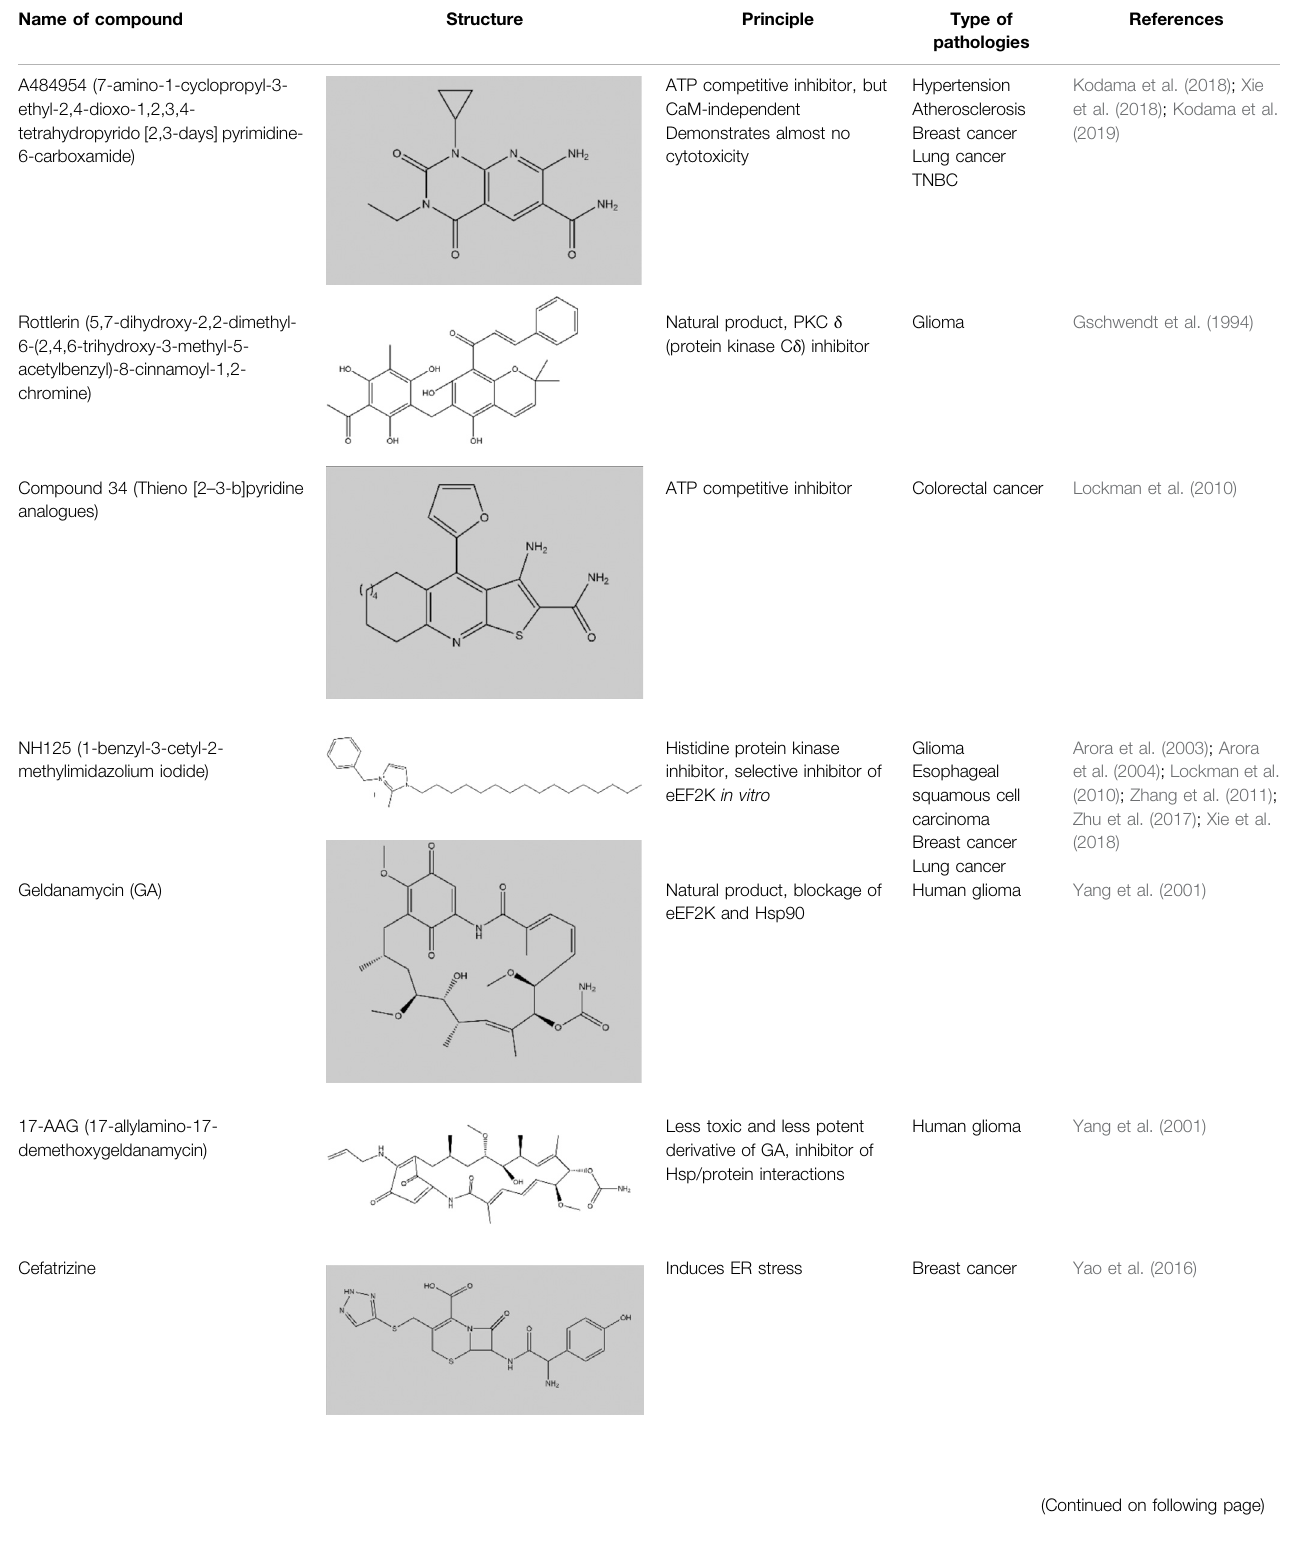
TABLE 2 | The inhibitors/activators targeting